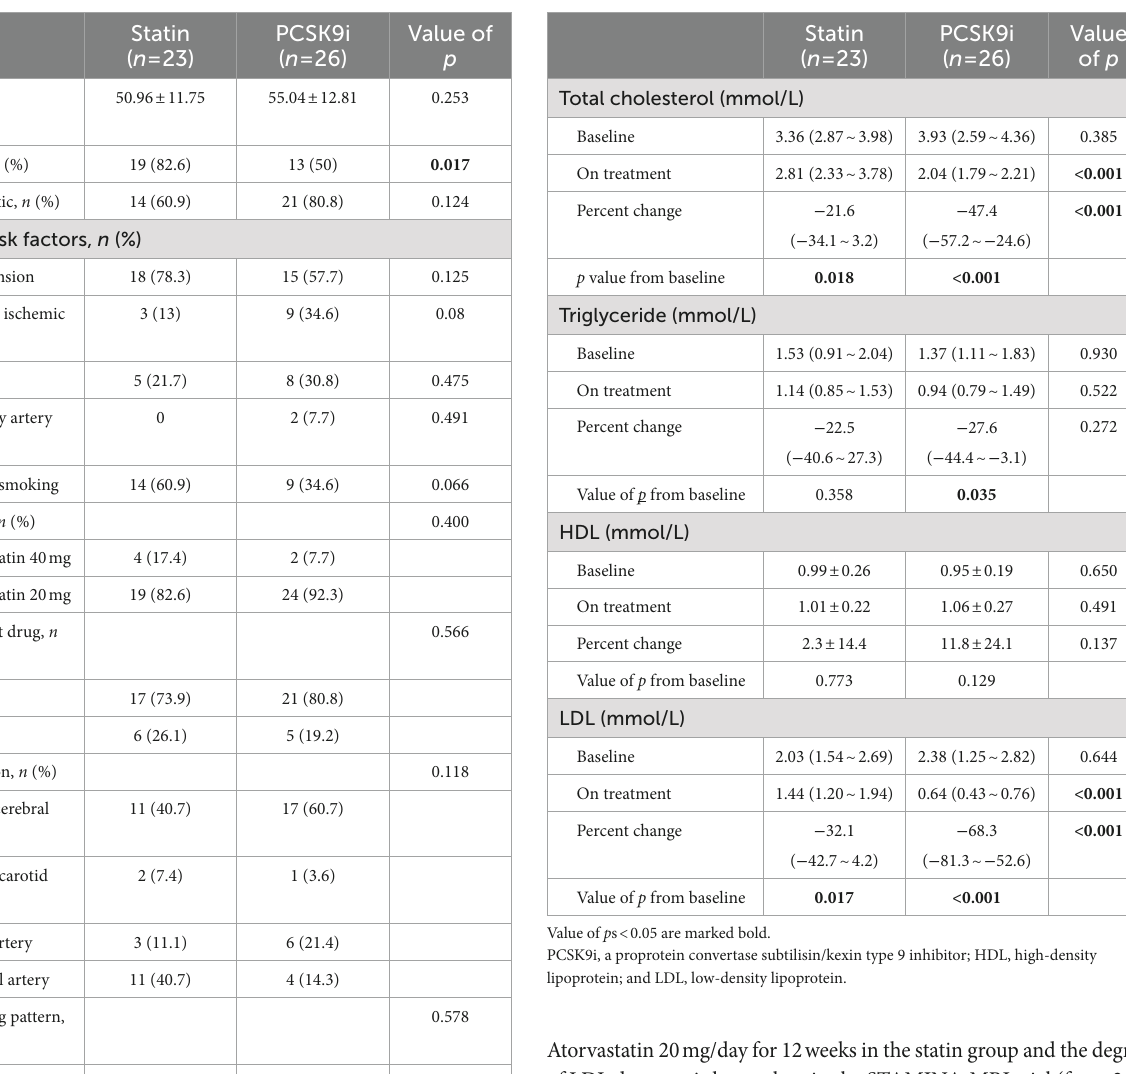
TABLE 1 Baseline characteristics. TABLE 2 Laboratory data.